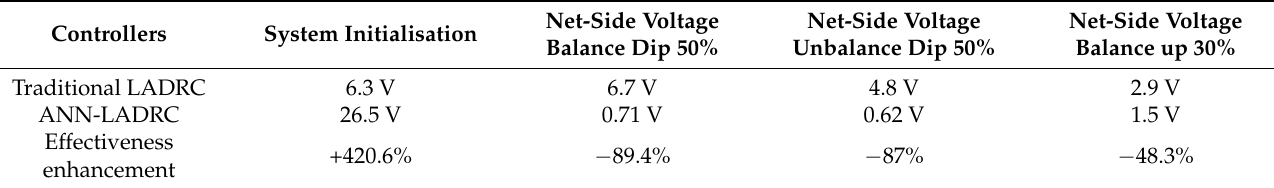
Table 1. DC bus voltage offset with different controllers.